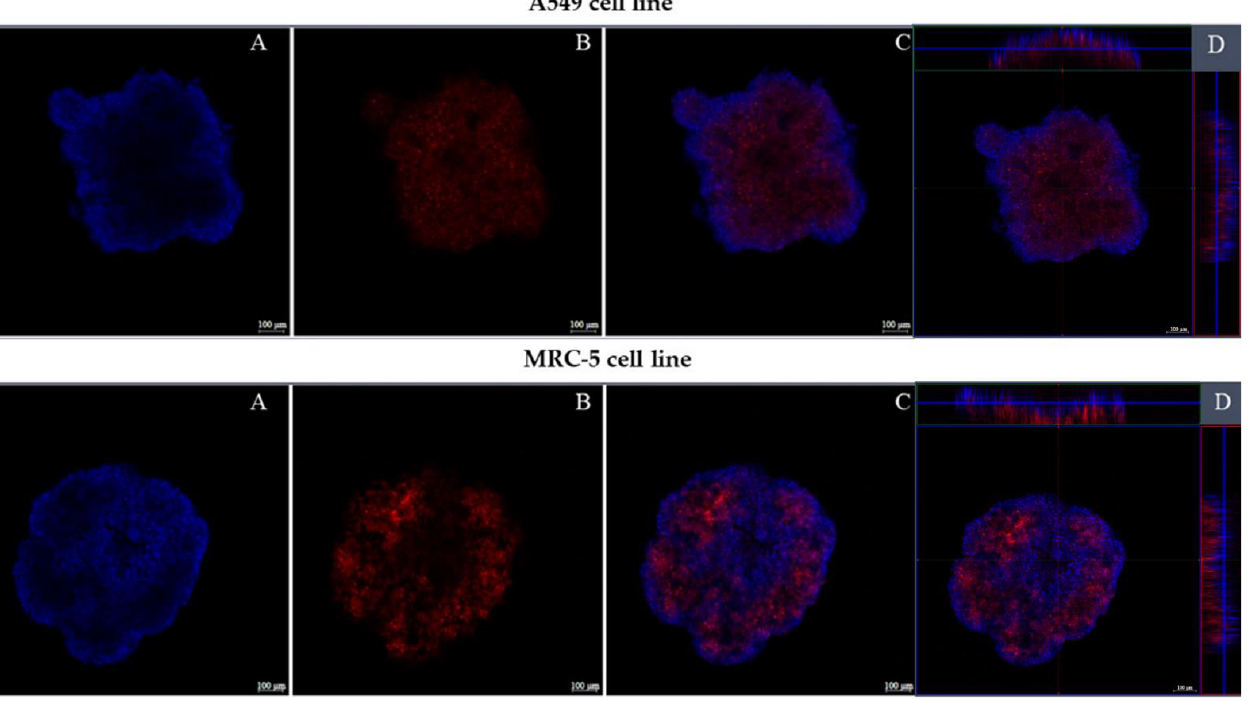
Table 4. Values of CC 50 (µg/mL) and SI for the A549 cell line in the monolayer and the 3D model treated with nitrofuran and indole derivatives.